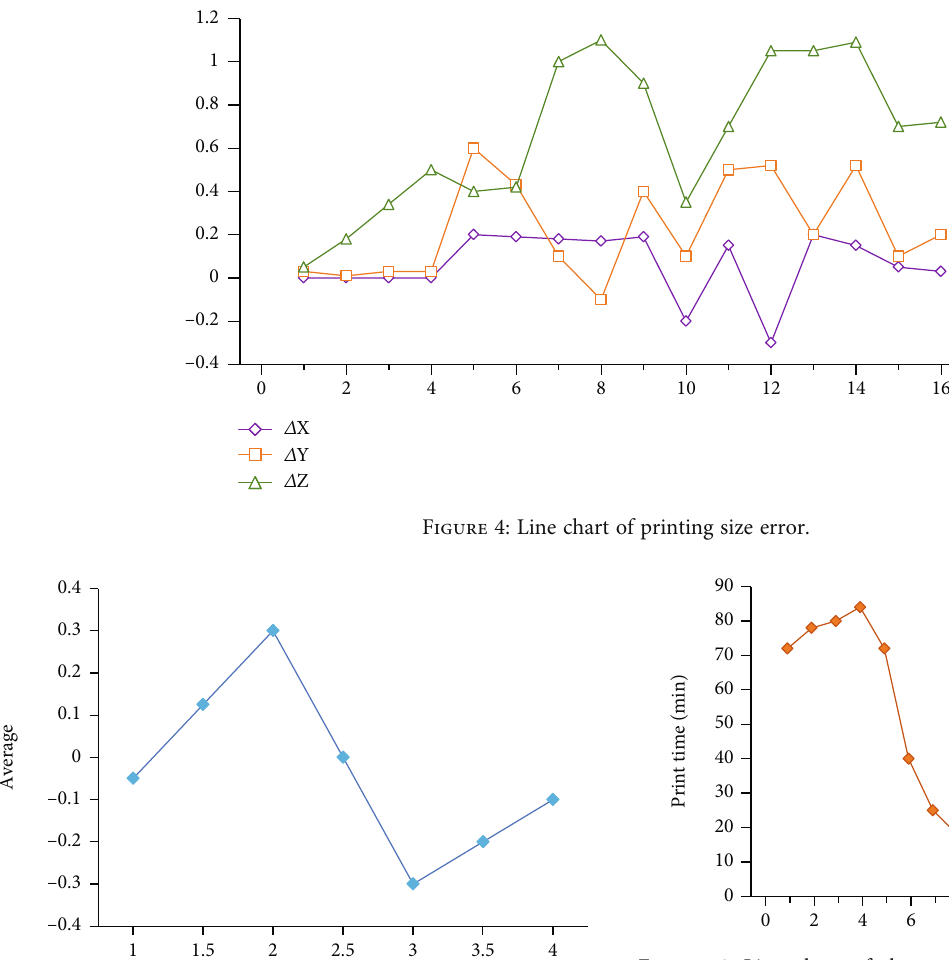
Figure 6: Line chart of the mean error of the factors in the experimental group of printing